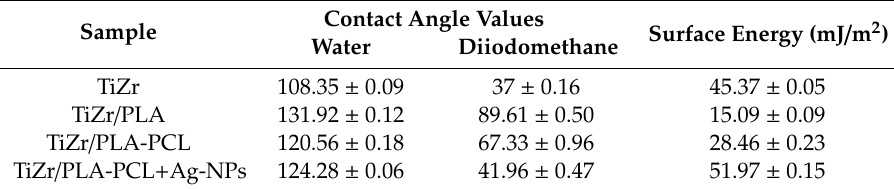
Table 3. Angle values and surface energy for samples.